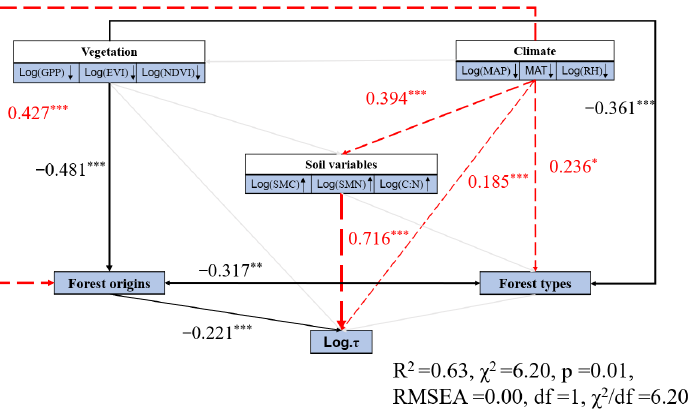
Figure A8. The main influencing factors of C turnover on the subsoil of the tropical zone were obtained by the SEM model. The symbols “ ↑ ” and “ ↓ ” indicate a positive or negative correlation between environmental factors and subsoil τ . The goodness of fit statistics for the effect size model of the relationship are as follows: * p < 0.05, *** p < 0.001.